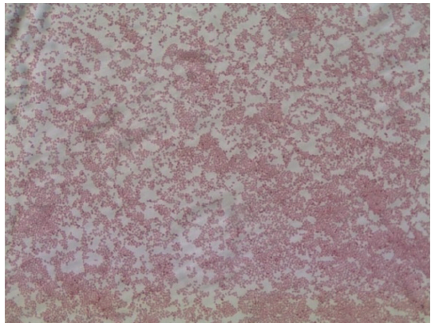
Figure 2: Gram-negative coccobacilli